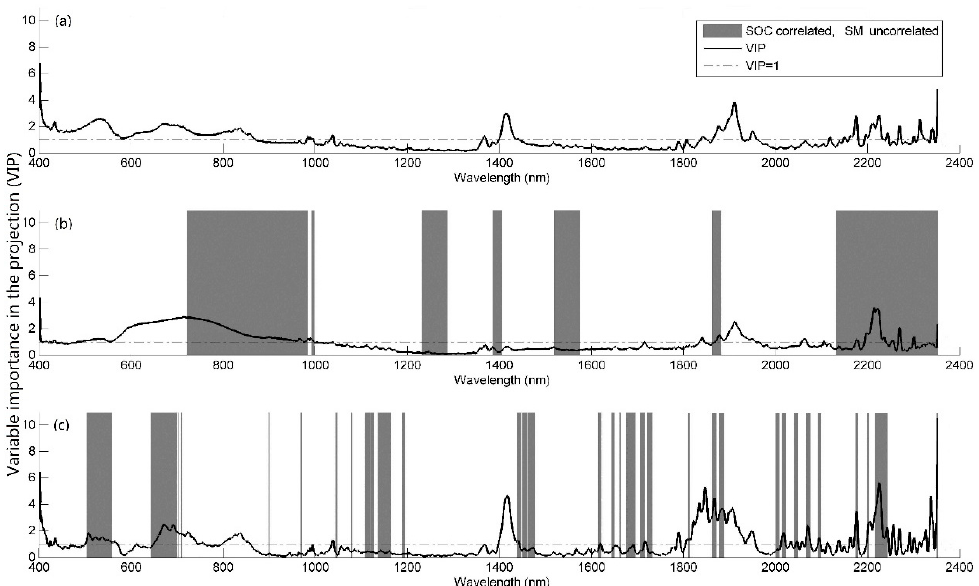
Figure 7. The variable importance in the projection (VIP) scores of the ( a ) PLSR; ( b ) OSC-PLSR; and ( c ) GLSW-PLSR modeling and the Pearson correlation between the SOC content and the three pretreated spectra by ( a ) SG smoothing; ( b ) OSC; and ( c ) GLSW (with soil moisture content (MC) = 150–200 g·kg − 1 as an example). The bands in significant correlation with the SOC content and uncorrelated with the MC were marked in gray ( p < 0.01).